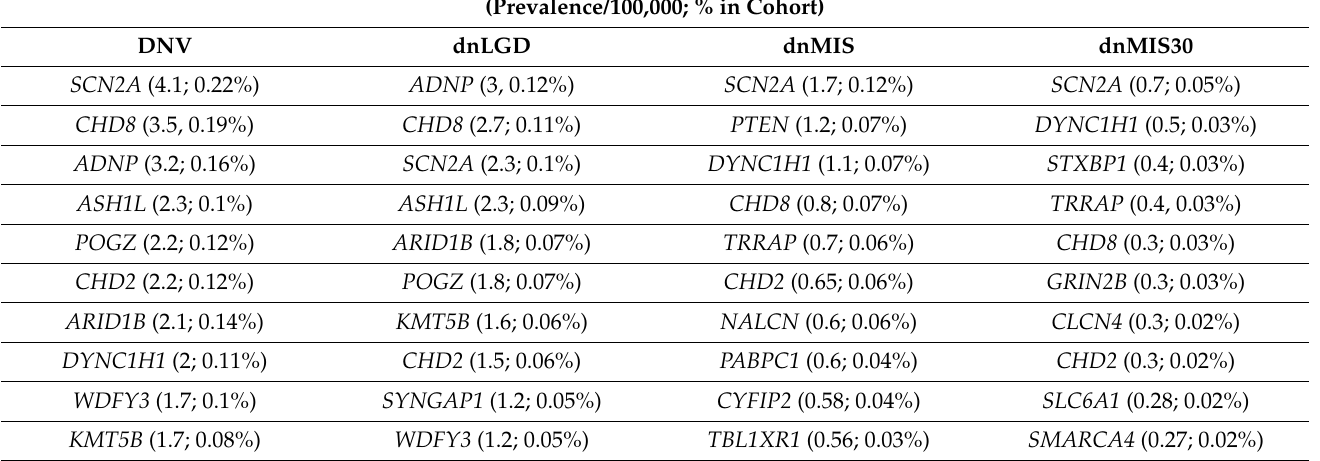
Figure 3. Prevalence of DNVs by gene extrapolated from number of cases in ASD cohort. Genes are indicated along the x -axis, with prevalence of each variant type on the y -axis. ( A ) ASD DNV cases, ( B ) ASD dnLGD cases, ( C ) ASD dnMIS cases, and ( D ) ASD dnMIS30 cases. The proportion of each gene and mutation type in our cohort was multiplied by the estimated prevalence of ASD from Zablotsky and Black, 2020. Table 5. Top 10 most prevalent genes with variation among ASD.